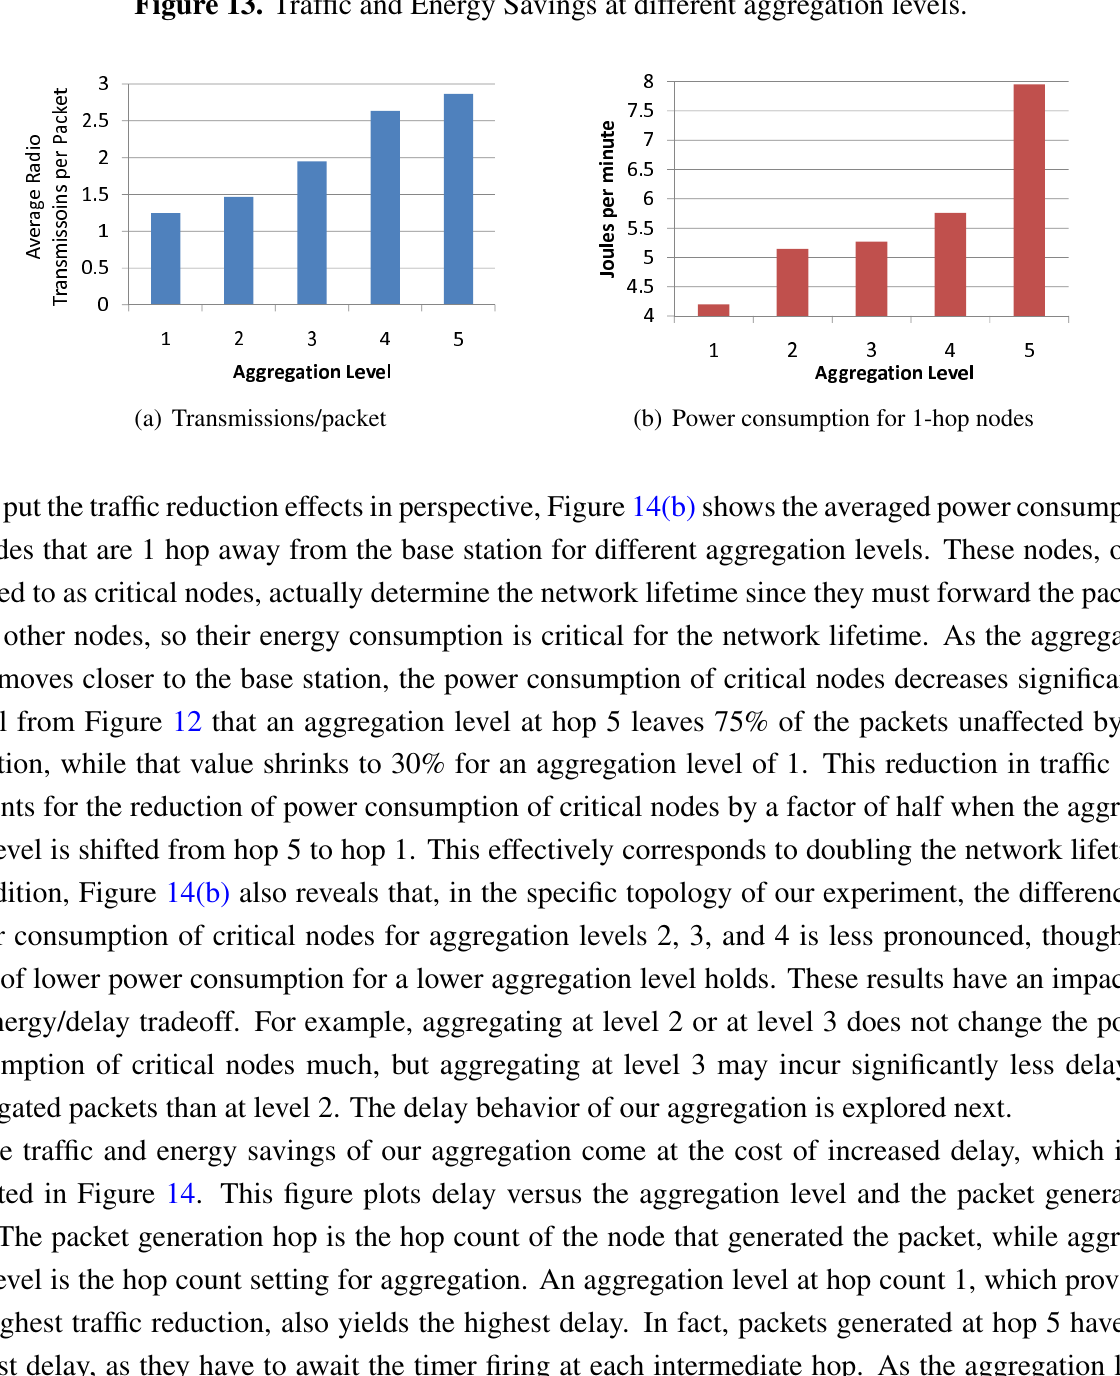
Figure 13. Traffic and Energy Savings at different aggregation